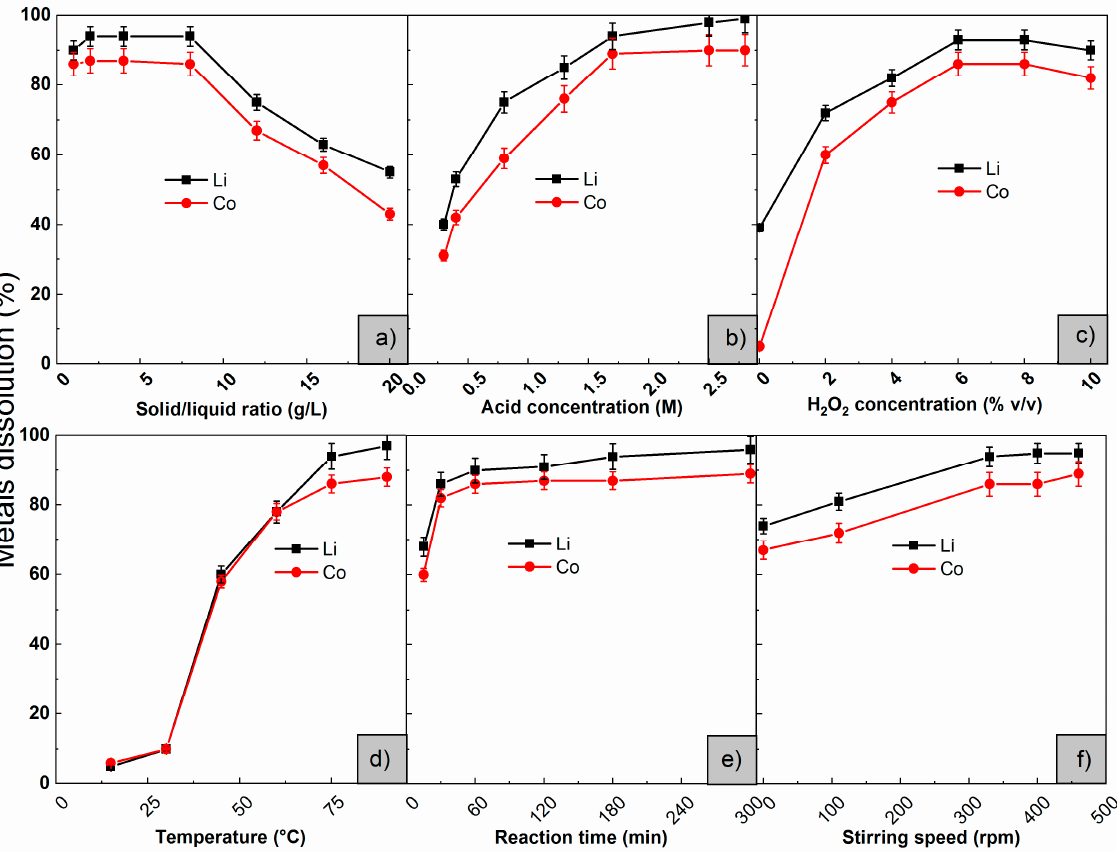
Figure 4. Effect of ( a ) solid/liquid ratio, ( b ) acid concentration, ( c ) H 2 O 2 concentration, ( d ) tempera- ture, ( e ) reaction time and ( f ) stirring